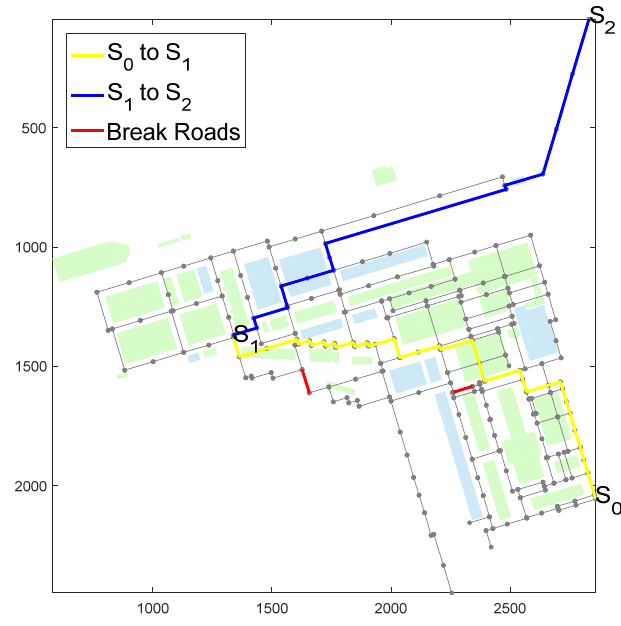
Figure 9. Schematic diagram of scheduling instance.